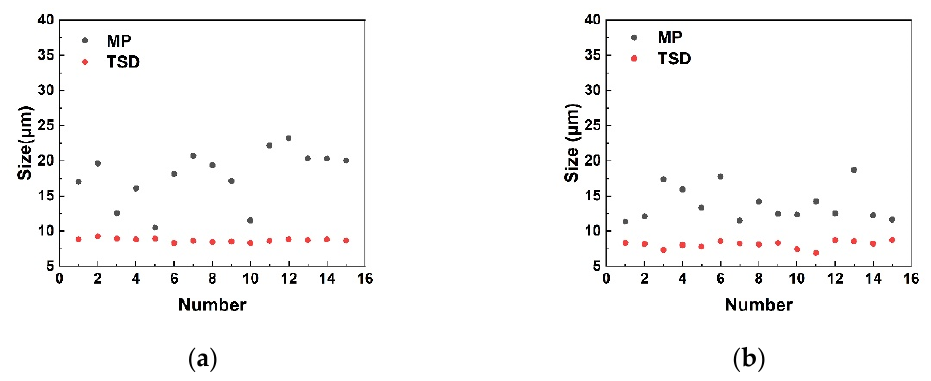
Figure 6. Comparison of micropipe etch pits and TSDs in size: ( a ) 4H-SiC; ( b ) 6H-SiC.